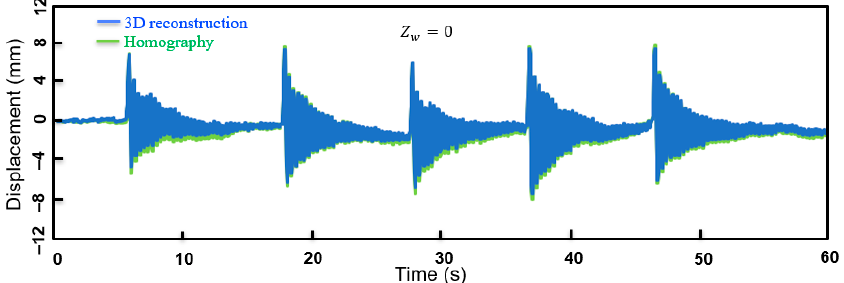
Figure 14. Comparison of displacement corrected by 3D reconstruction and homography methods ( Z w = 0).